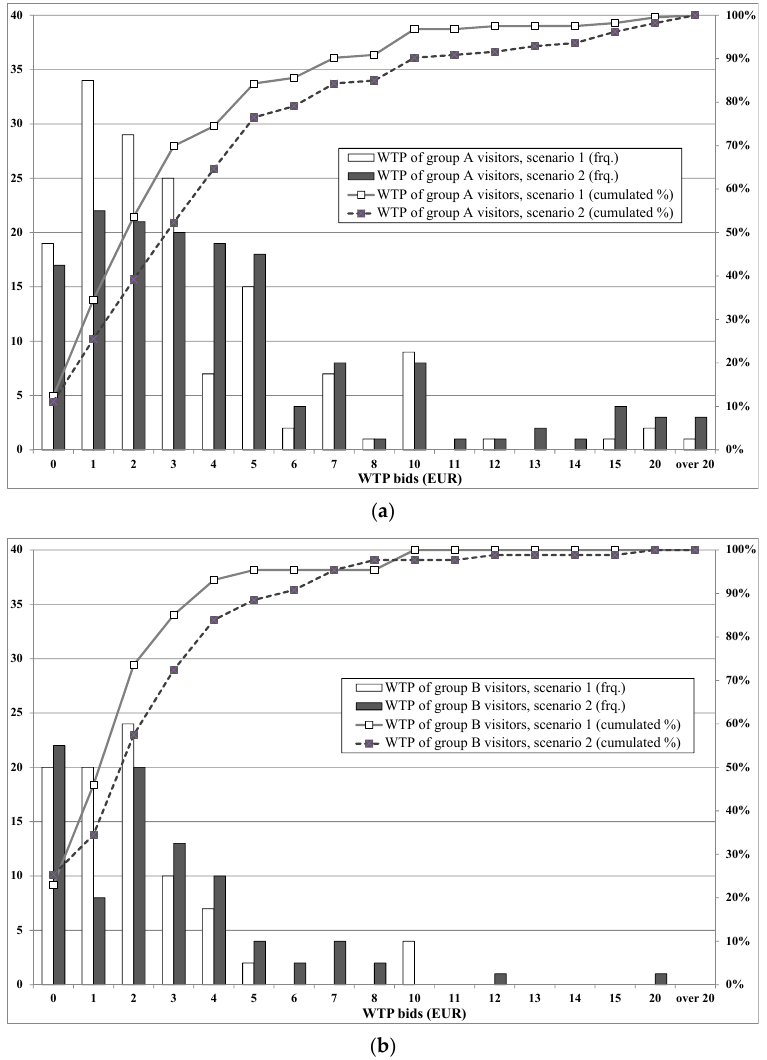
Figure 3. Frequency and cumulated percent of WTP bids (in EUR) of respondents: ( a ) group A visitors ( n = 153); ( b ) group B visitors ( n = 87).